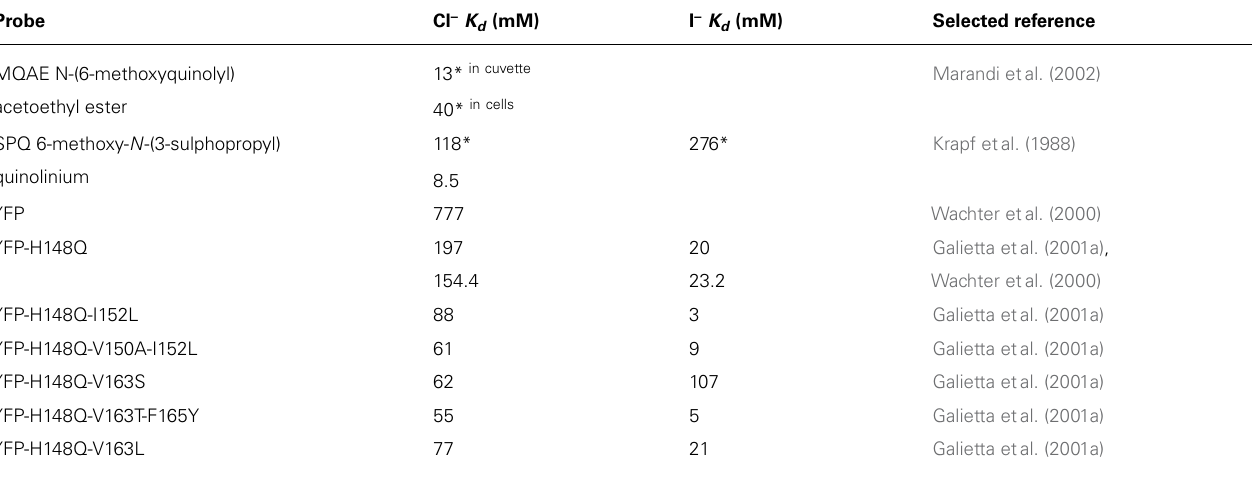
Table 1 | Chloride and iodide affinity for various probes at pH 7.5 and room temperature.